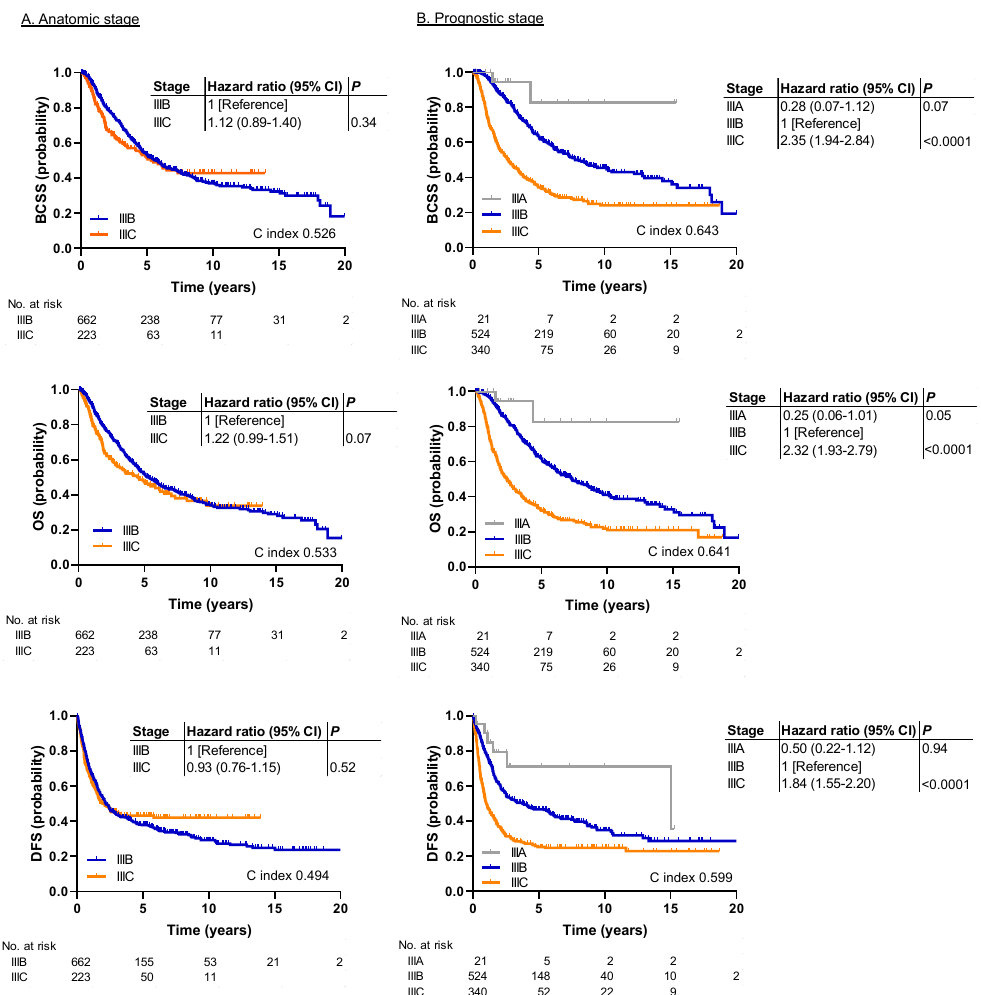
Figure 1. Kaplan-Meier survival plots demonstrating the association between the anatomic/prognostic staging systems and survival outcomes in the patients treated at The University of Texas MD Anderson Cancer Center (MDA cohort). ( A ) Survival analysis by anatomic stage for BCSS, OS, and DFS. No statistically significant differences were observed. ( B ) Survival analysis by prognostic stage for BCSS, OS, and DFS. There were significant differences for all endpoints. BCSS, breast cancer-specific survival; DFS, disease free survival; HR, hazard ratio; OS, overall survival.